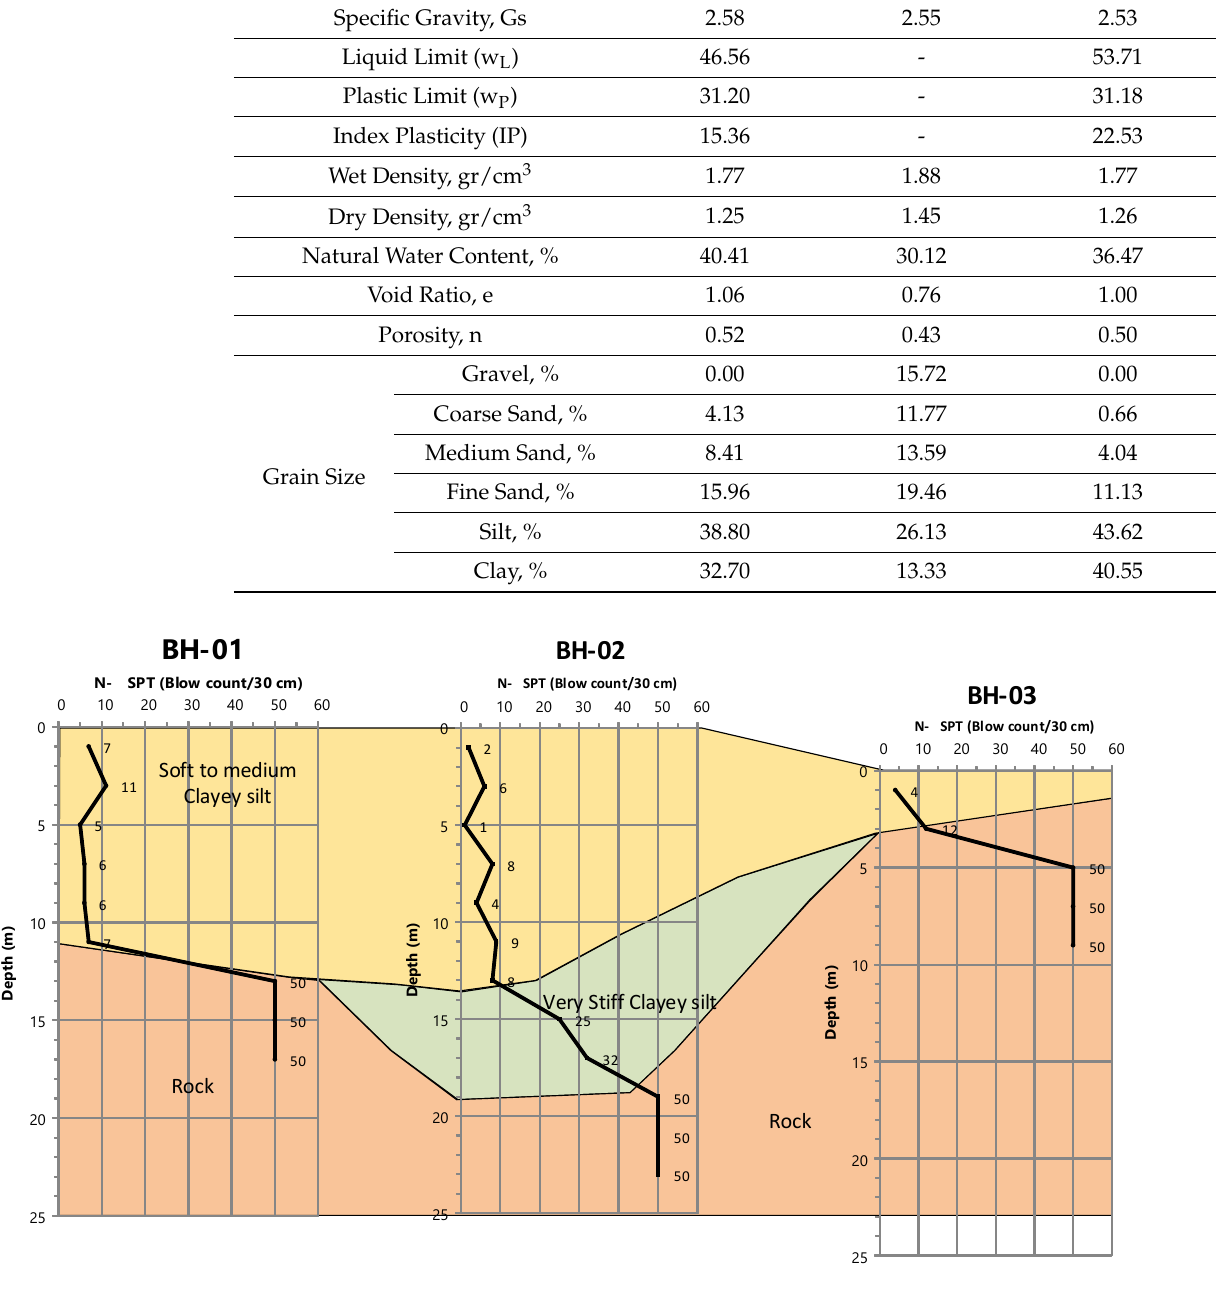
Figure 6. Soil layer according to borehole data. Table 1. Boreholes and CPT coordinates.